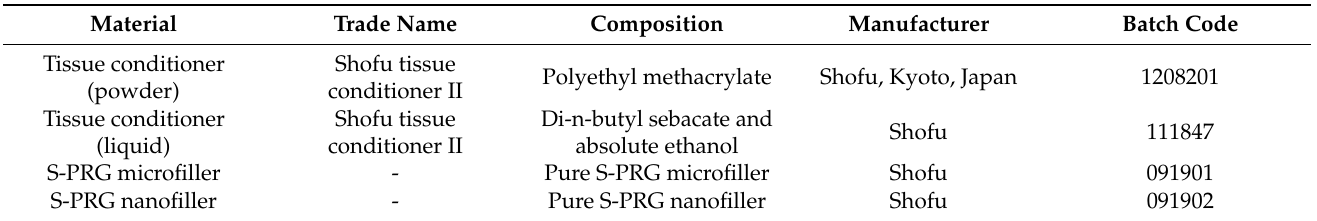
Table 1. Trade name, manufacturer, composition, and batch code of materials used in this study.